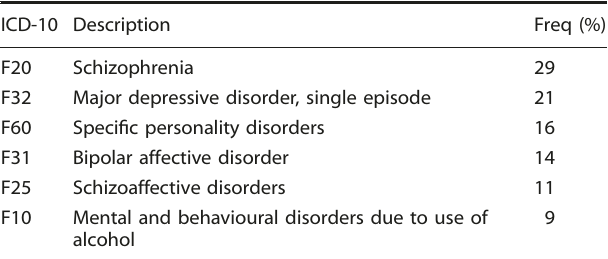
Table 1. Mental health diagnoses from discharge summaries in the CRIS database. We report frequency for test-gen-mhr